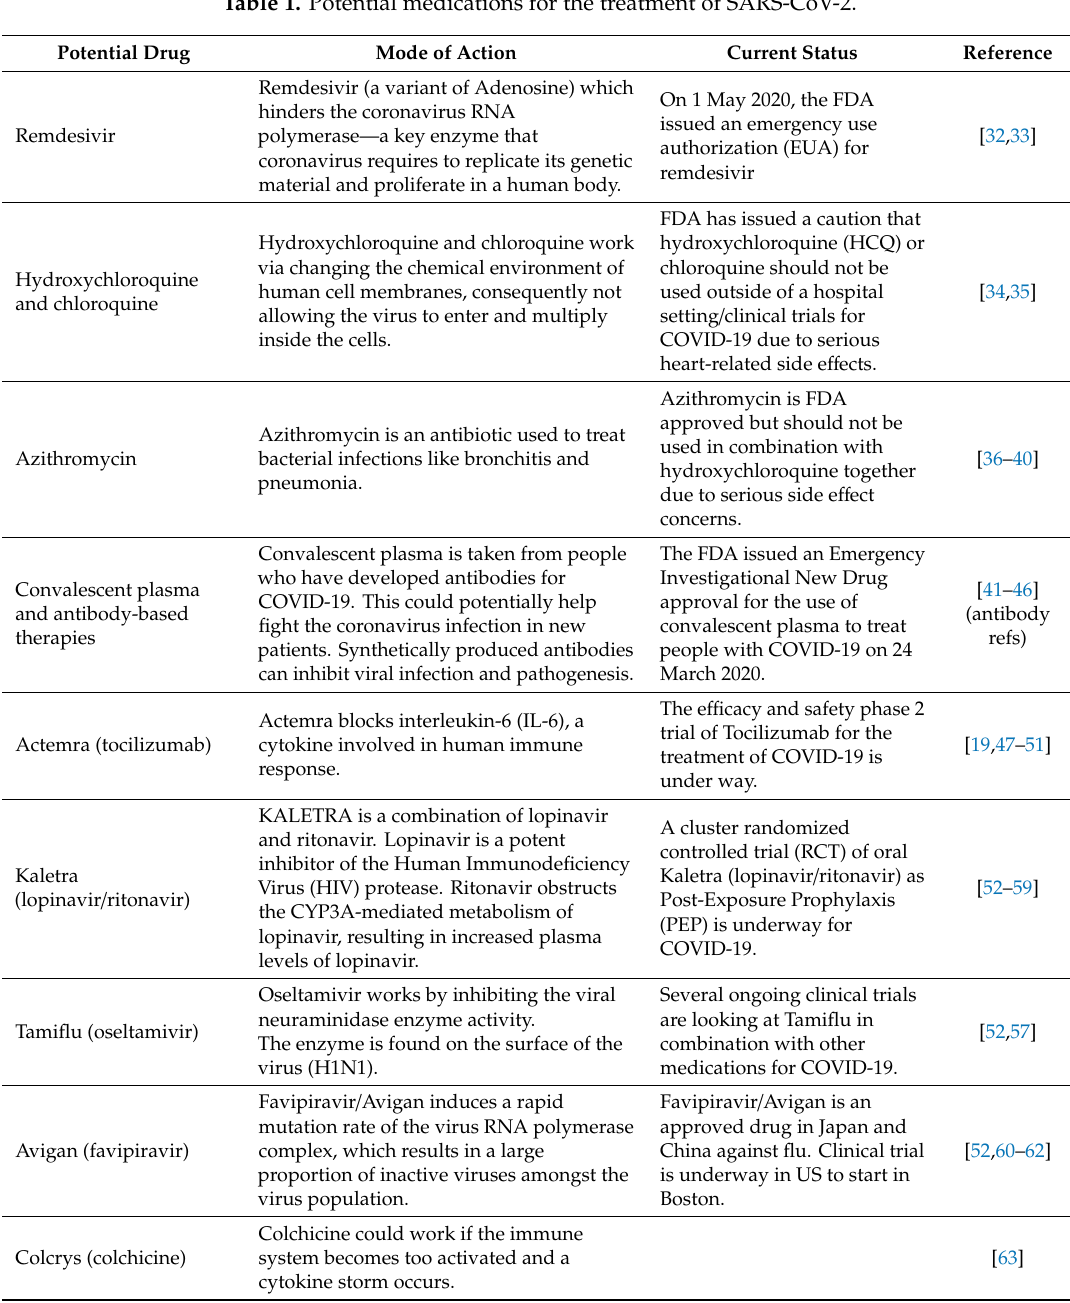
Table 1. Potential medications for the treatment of